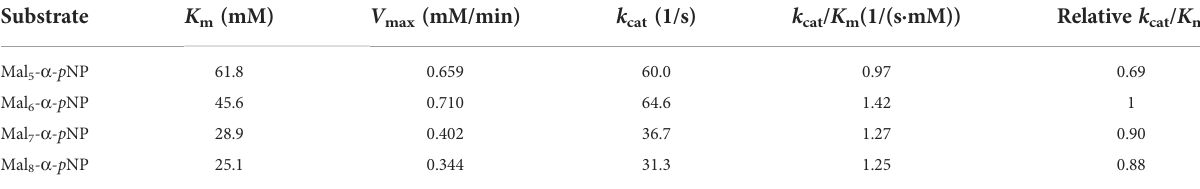
TABLE 3 Kinetic parameters of rAoAgtA for the degradation of Mal 5 – 8 - a - p NP.